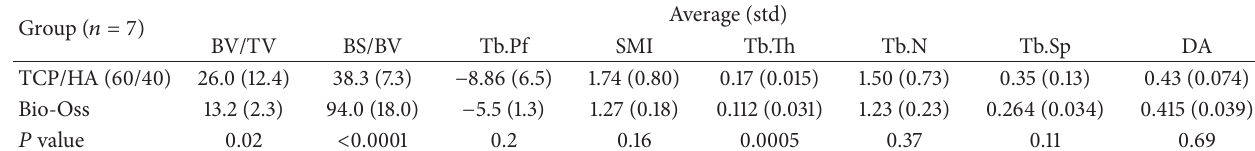
Table 3: Micro-CT results after 8 weeks of implantation.